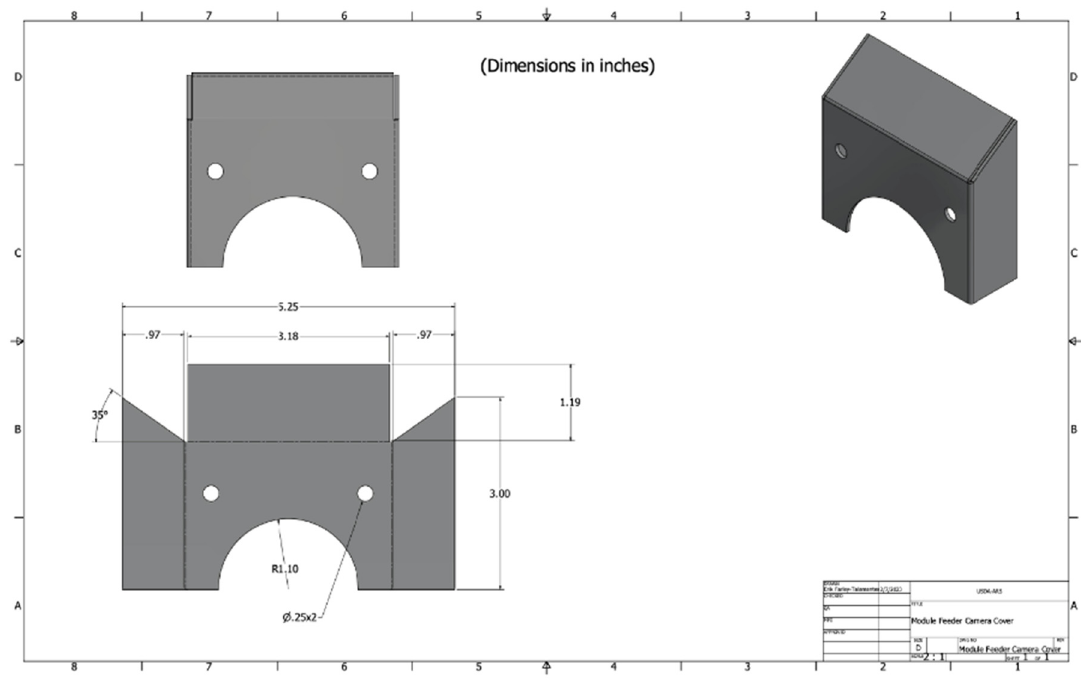
Figure 11. Module feeder camera housing middle section (#2 of assembly drawing).